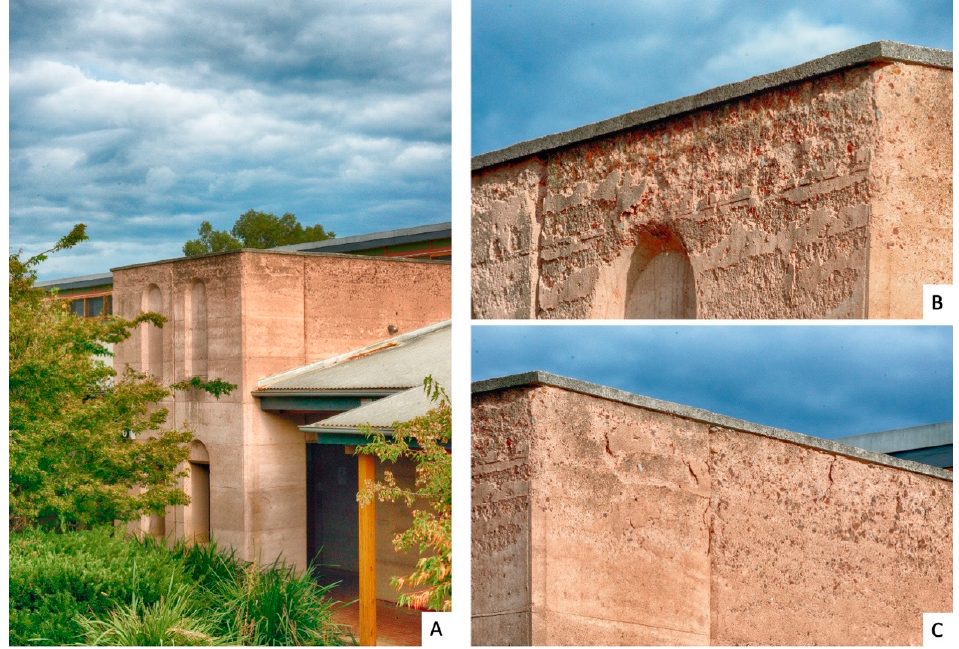
Figure 21. Parapet over the entrance to building 761, seen from southeast: ( A ) the portico; ( B ) decay below the capping, southern façade; ( C ) decay below the capping, eastern façade.